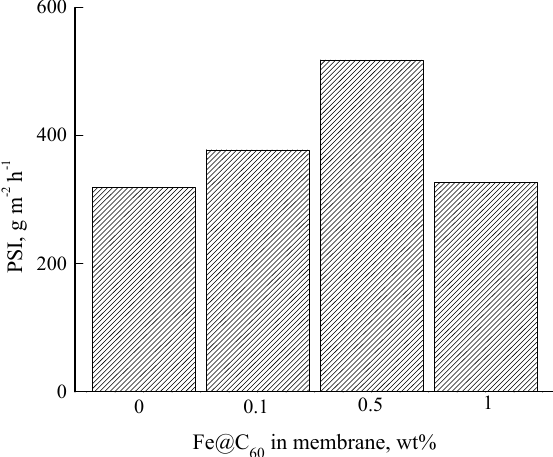
Figure 5. Dependence of the pervaporation separation index (PSI) on Fe@C 60 content in the membrane in the pervaporation of the methanol—methyl acetate (18:82 wt %) azeotropic mixture, 25 ° С .